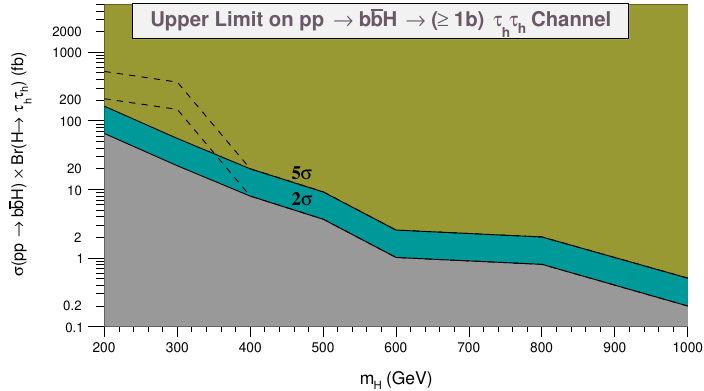
Figure 37 . Upper limit on (cid:27) ( pp 1 b + 2 (cid:28) h channel. The solid (dashed) lines show the 2 (cid:27) -5 (cid:27) band on taking 0% (5%) systematic (cid:21)